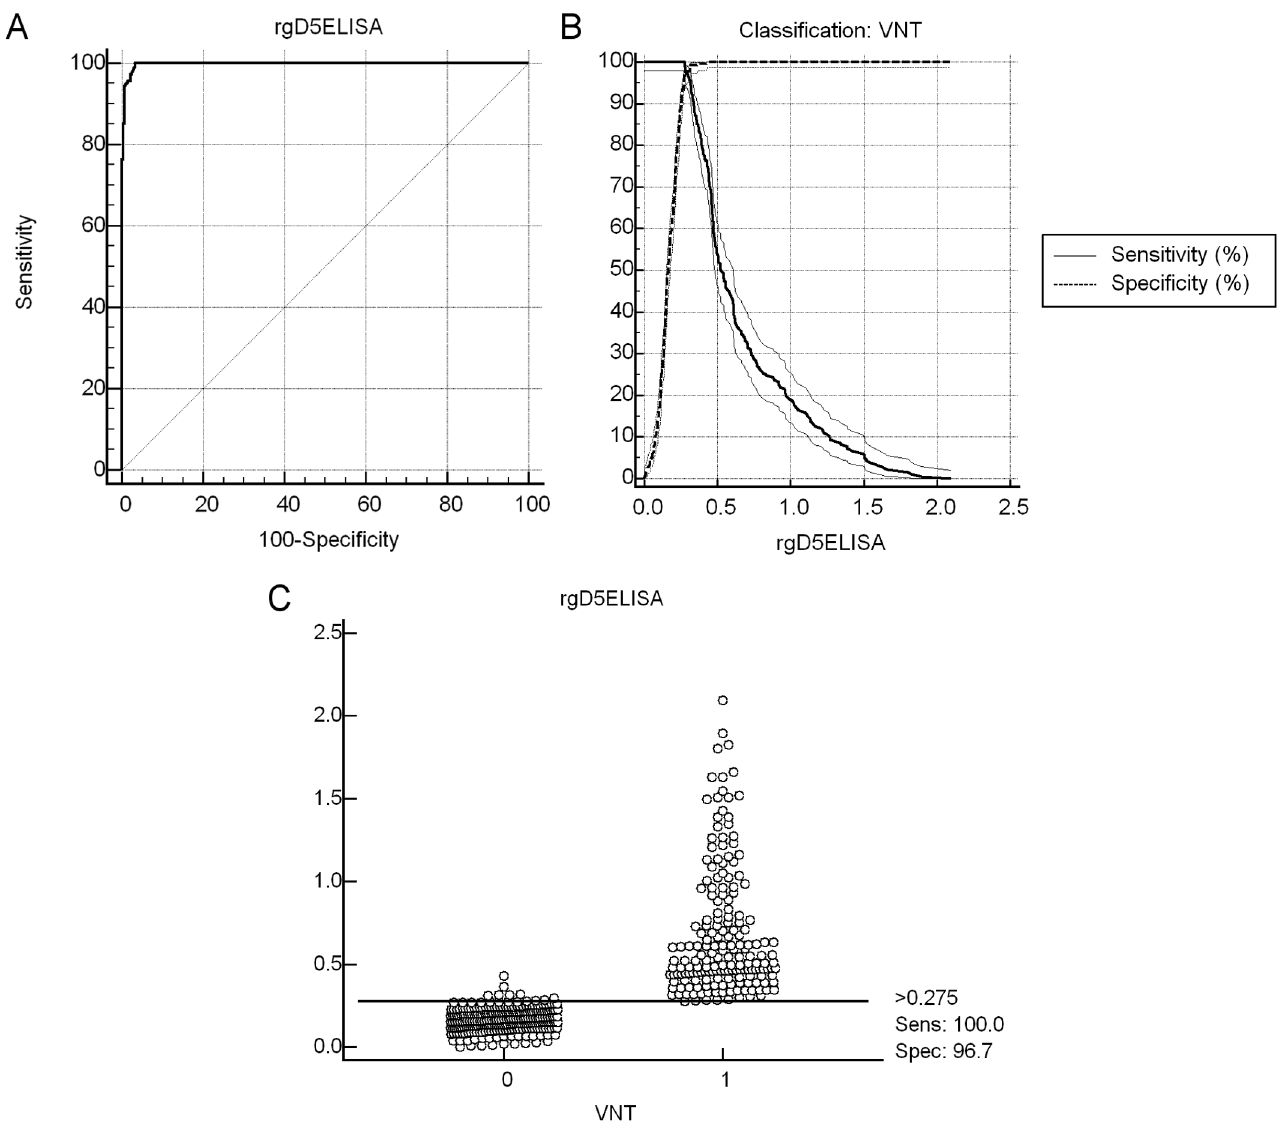
Fig 2. Receiver-Operating Characteristics Analysis of the Developed rgD5ELISA. (A) Receiver-operating characteristics (ROC) curves based on test results obtained for the rgD5ELISA ( n = 450). (B) Relationship between ROC-based estimates for test sensitivity and specificity and rgD5ELISA cut-offs; (C) Interactive dot diagram based on rgD5ELISA outcomes in relation to virus neutralization test (VNT negative = 0 and VNT positive = 1).